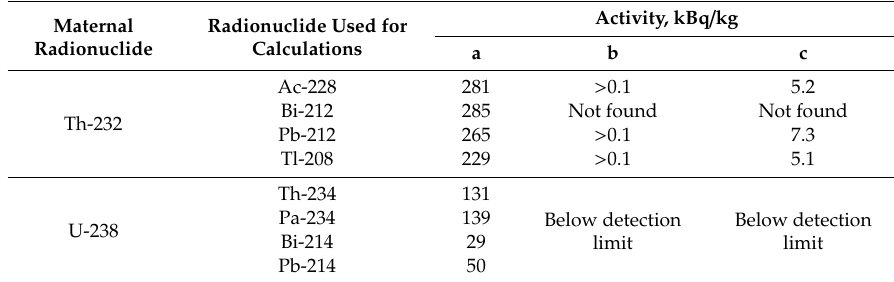
Table 2. Activity (kBq / L) determined by gamma spectrometry of samples: (a) oxide and hydrated precipitates of REEs, uranium and thorium obtained after autoclave processing of monazite concentrate; (b) phosphate-alkaline solutions and wash water; (c) nitric acid solution obtained by dissolving oxide and hydrated sediments of REEs, uranium and thorium. Maternal Radionuclide